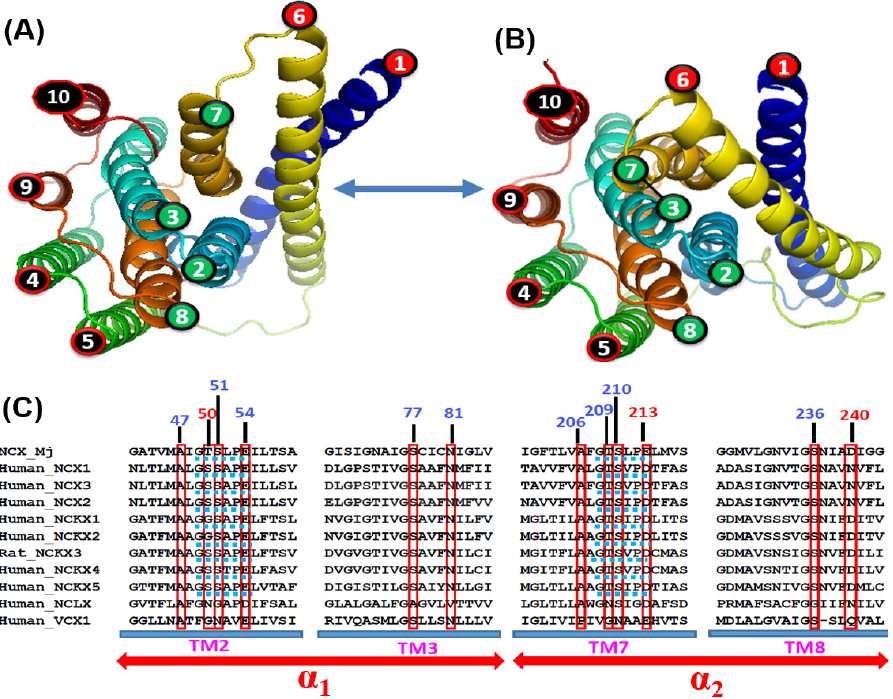
Figure 3. Structural organization and sequence alignment of ion-coordinating residues in NCXs and similar proteins. The sliding mechanism is a distinct variant of the alternating access mechanism while describing specific conformational changes associated with the OF/IF swapping. The open (X-ray structure) ( A ) and closed (computed) ( B ) structures of NCX_Mj at the extracellular side. Upon ion binding, the two-helix sliding bundle, TM1/TM6 (presented in red), might relocates in front of other helixes to swap the OF and IF states. ( C ) Sequence alignment of NCX, NCKX, NCLX, and CAX antiporters (belonging to the superfamily of Ca 2+ /CA antiporters). Twelve ion-coordinating residues (in red boxes), attached to four helixes (TM2, TM3, TM7, and TM8) form an ion-passageway entity. The ion-coordinating residues are highly conserved in Ca 2+ /CA proteins—e.g., the NCX_Mj and mammalian NCXs have three (out of twelve) different ion-coordinating residues (T50S, E213D and D240N) although their transport rates differ by several orders of magnitude.